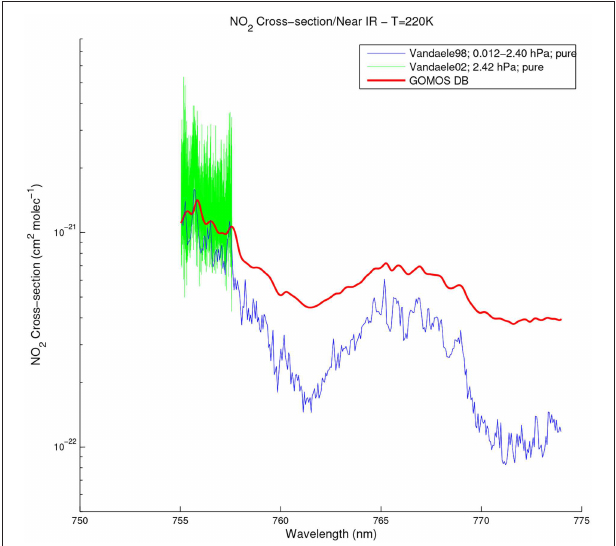
FIGURE 4 | NO 2 absorption cross-section spectra between 750 and 776 nm at 220 K, observed by Vandaele et al. (1998) at 0.5 Torr (blue), and Vandaele et al. (2002) in the case of pure NO 2 (green). The absorption cross-section provided by GOMOS DB at the same temperature is shown in red for